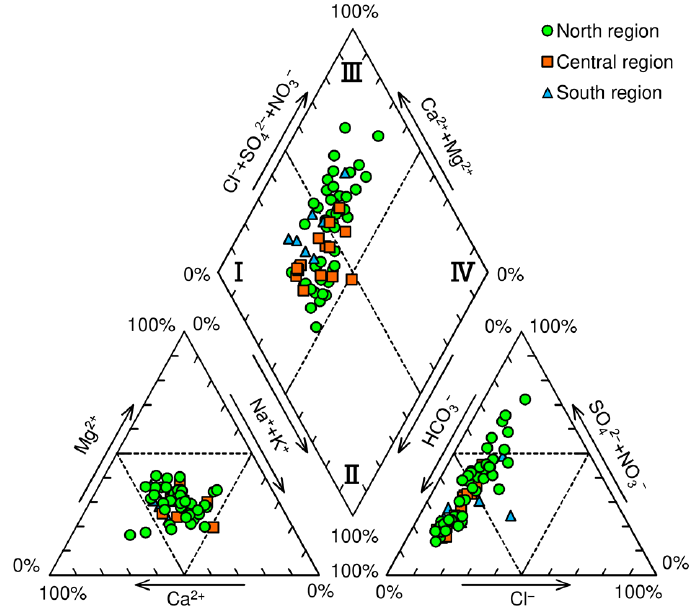
Figure 4. Trilinear Piper diagram of groundwater in the three regions.